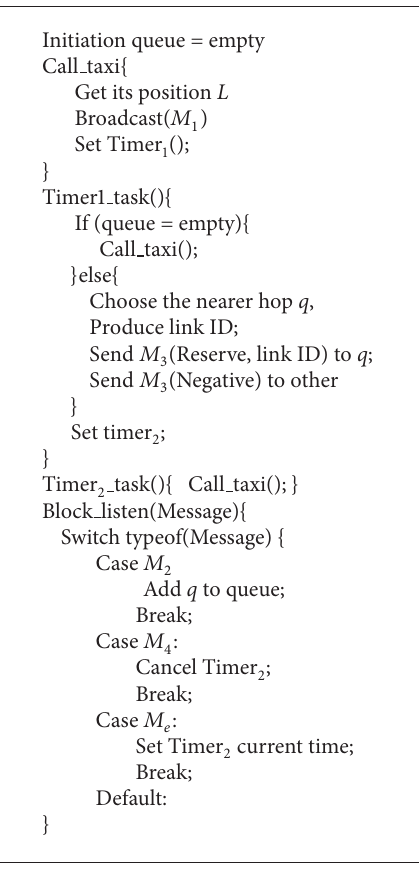
Algorithm 2: Algorithm of passenger